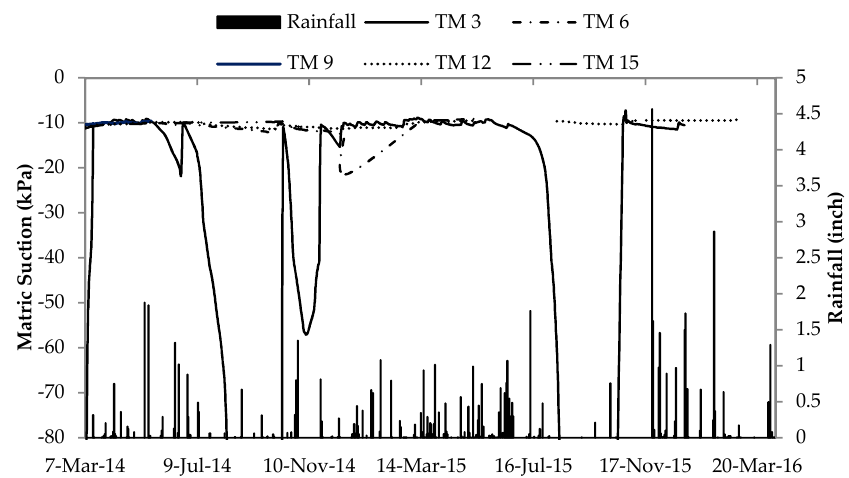
Figure 13. Matric suction at SH 342 site from 2014–16.